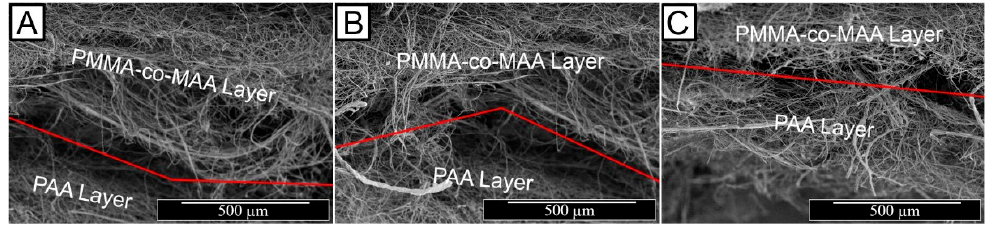
Figure 2. SEM images of the two-layer membrane cross-section displaying the thermally-crosslinked PAA wound contact layer and the BTB-loaded PMMA-co-MAA infection-responsive top layer. ( A ): PAA*(PMMA-co-MAA)30 ( ρ a : 1.27 g · cm − 2 ); ( B ): PAA*(PMMA-co-MAA)20 ( ρ a : 3.88 g · cm − 2 ; ( C ): PAA*(PMMA-co-MAA)10 ( ρ a : 8.86 g · cm − 2 ).